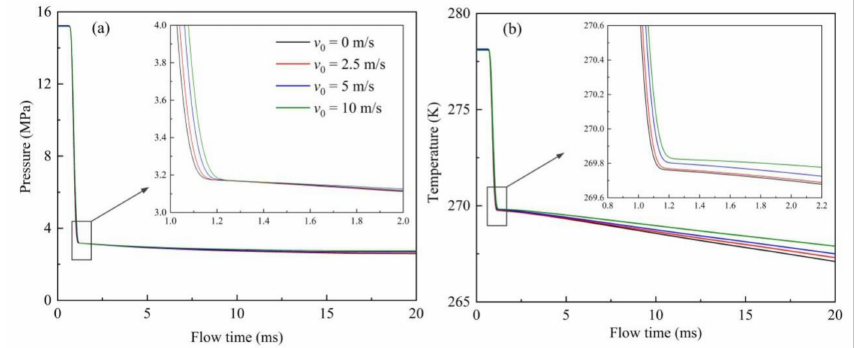
Figure 6. Effects of flow velocity on ( a ) pressure and ( b ) temperature.